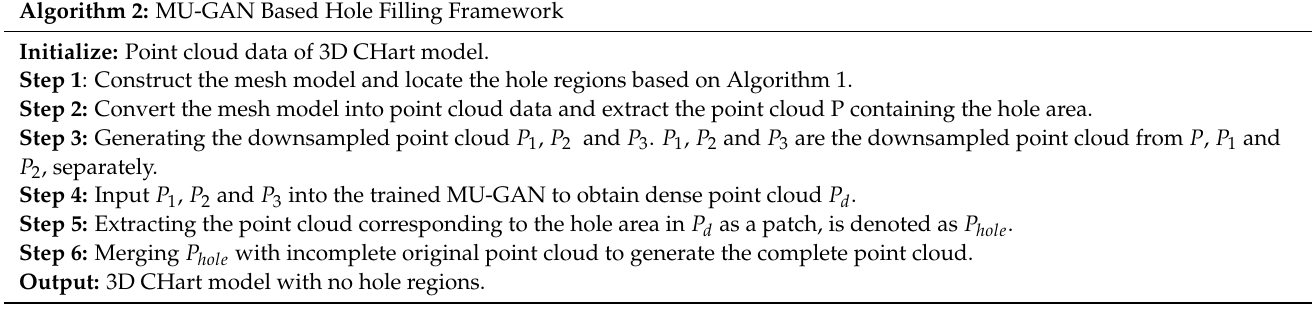
Algorithm 2: MU-GAN Based Hole Filling